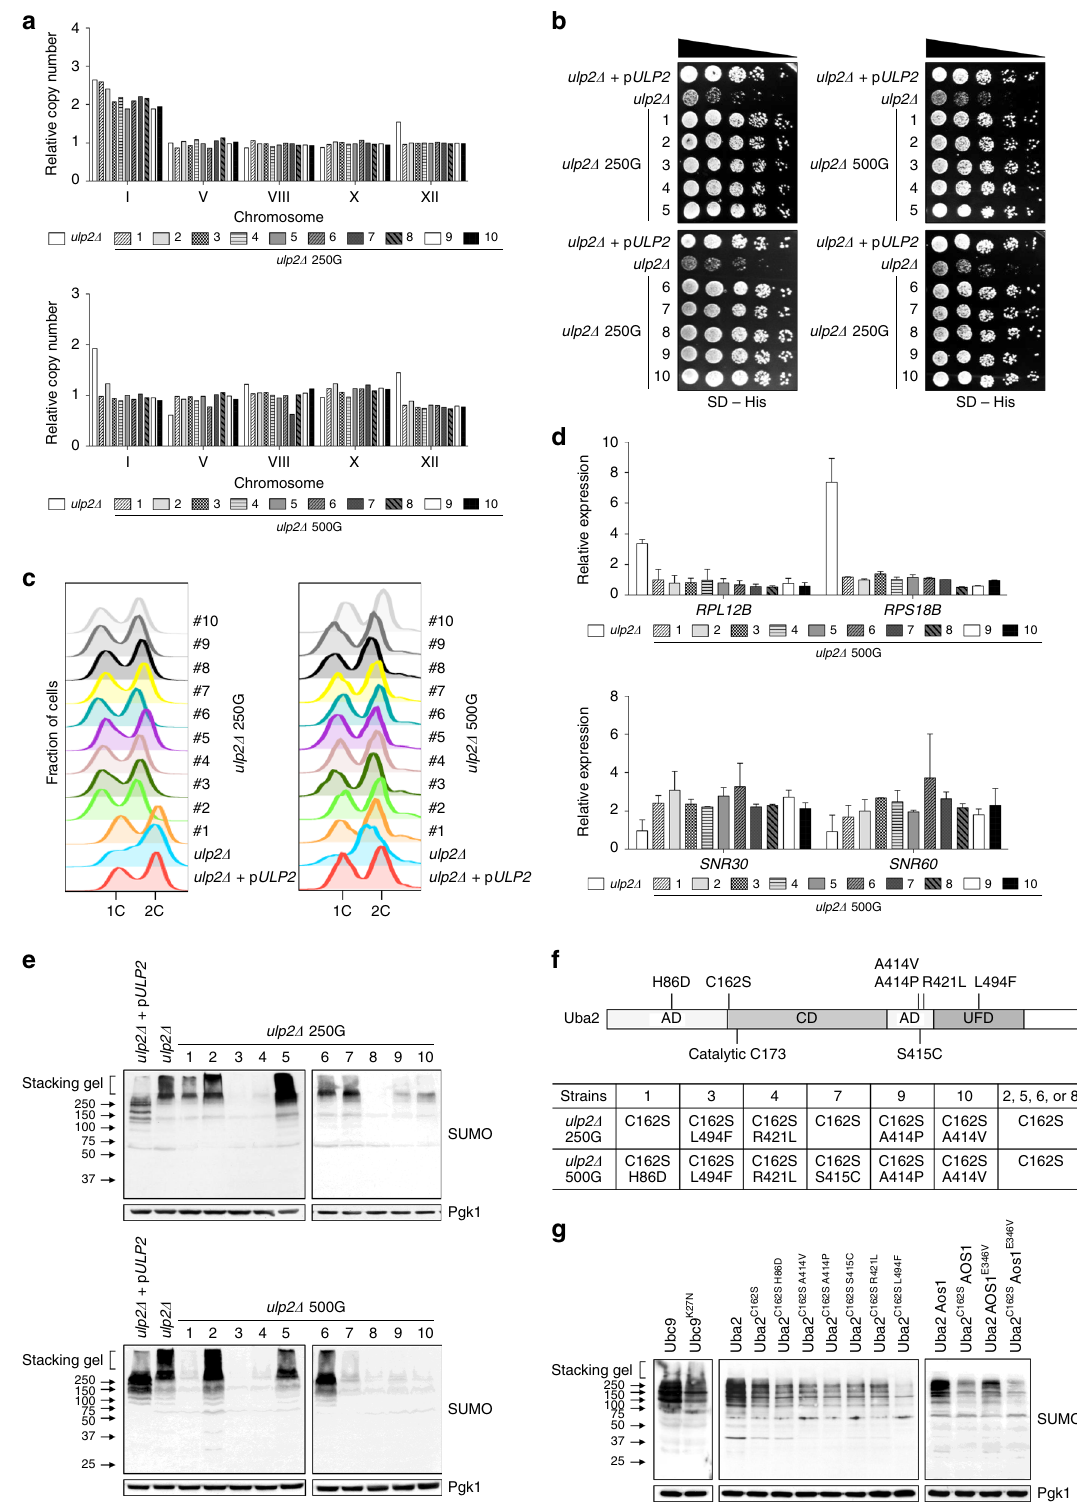
Fig. 5 UBA2 and AOS1 genes are mutated in high-passage ulp2 Δ cells. a – e qPCR ploidy assays ( a ), growth assays ( b ), fl ow cytometry analysis ( c ), qRT-PCR analysis of ribosomal protein genes RPL12B and RPS18B and snoRNA genes SNR30 or SNR60 ( d ), and immunoblot analysis of SUMO-conjugated proteins ( e ) were performed for ten independently evolved ulp2 Δ lines at 250 or 500 generations. Gene expression was measured relative to WT cells (MHY1379) and data were normalized to SPT15 expression in d . The error bars indicate the SD from two experiments. f Schematic of Uba2 protein and list of mutations in ulp2 Δ 250G or 500G strains. AD, CD, and UFD indicate adenylation, Cys and ubiquitin-like fold domains, respectively. Positions of the catalytic Cys residue and mutations identi fi ed in Table 2 are noted. g ubc9 Δ , uba2 Δ , or uba2 Δ aos1 Δ strains carrying a YCplac33 plasmid with UBC9 , UBA2 , or UBA2 AOS1 were transformed with a pRS315 plasmid expressing WT or the indicated mutant proteins. After shuf fl ing out the URA3 -marked plasmids, anti-SUMO immunoblot analysis of cell extracts was